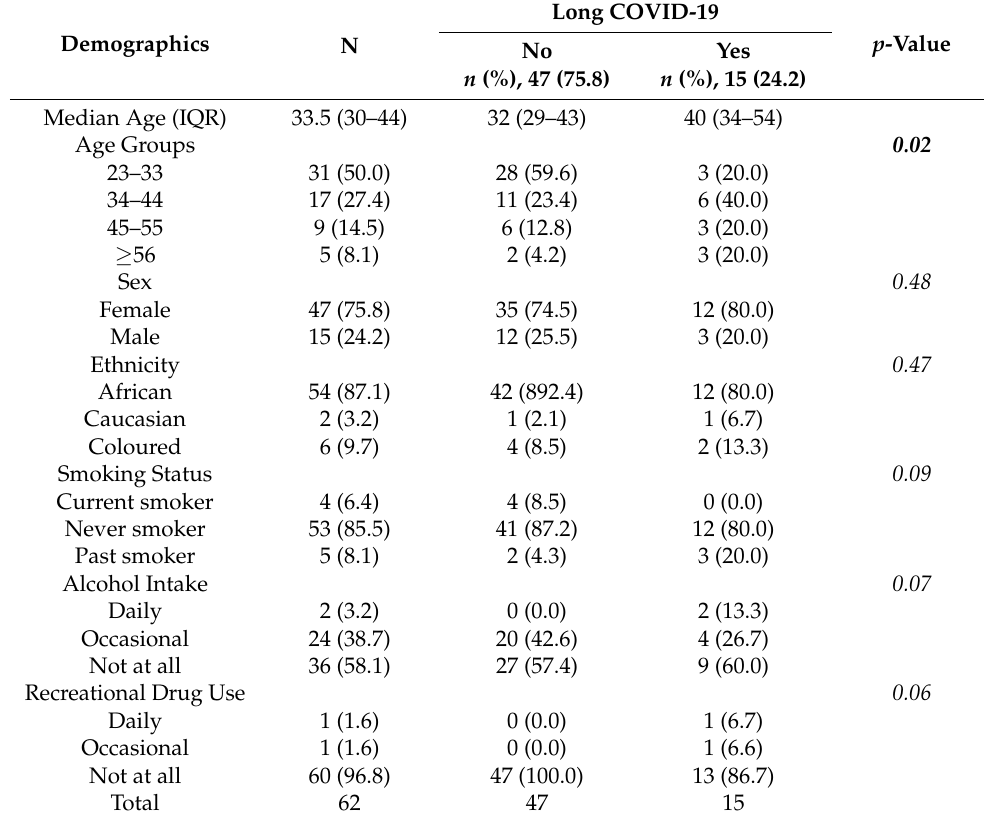
Table 2. Characteristics of survey respondents with long COVID-19 ( n = 15).